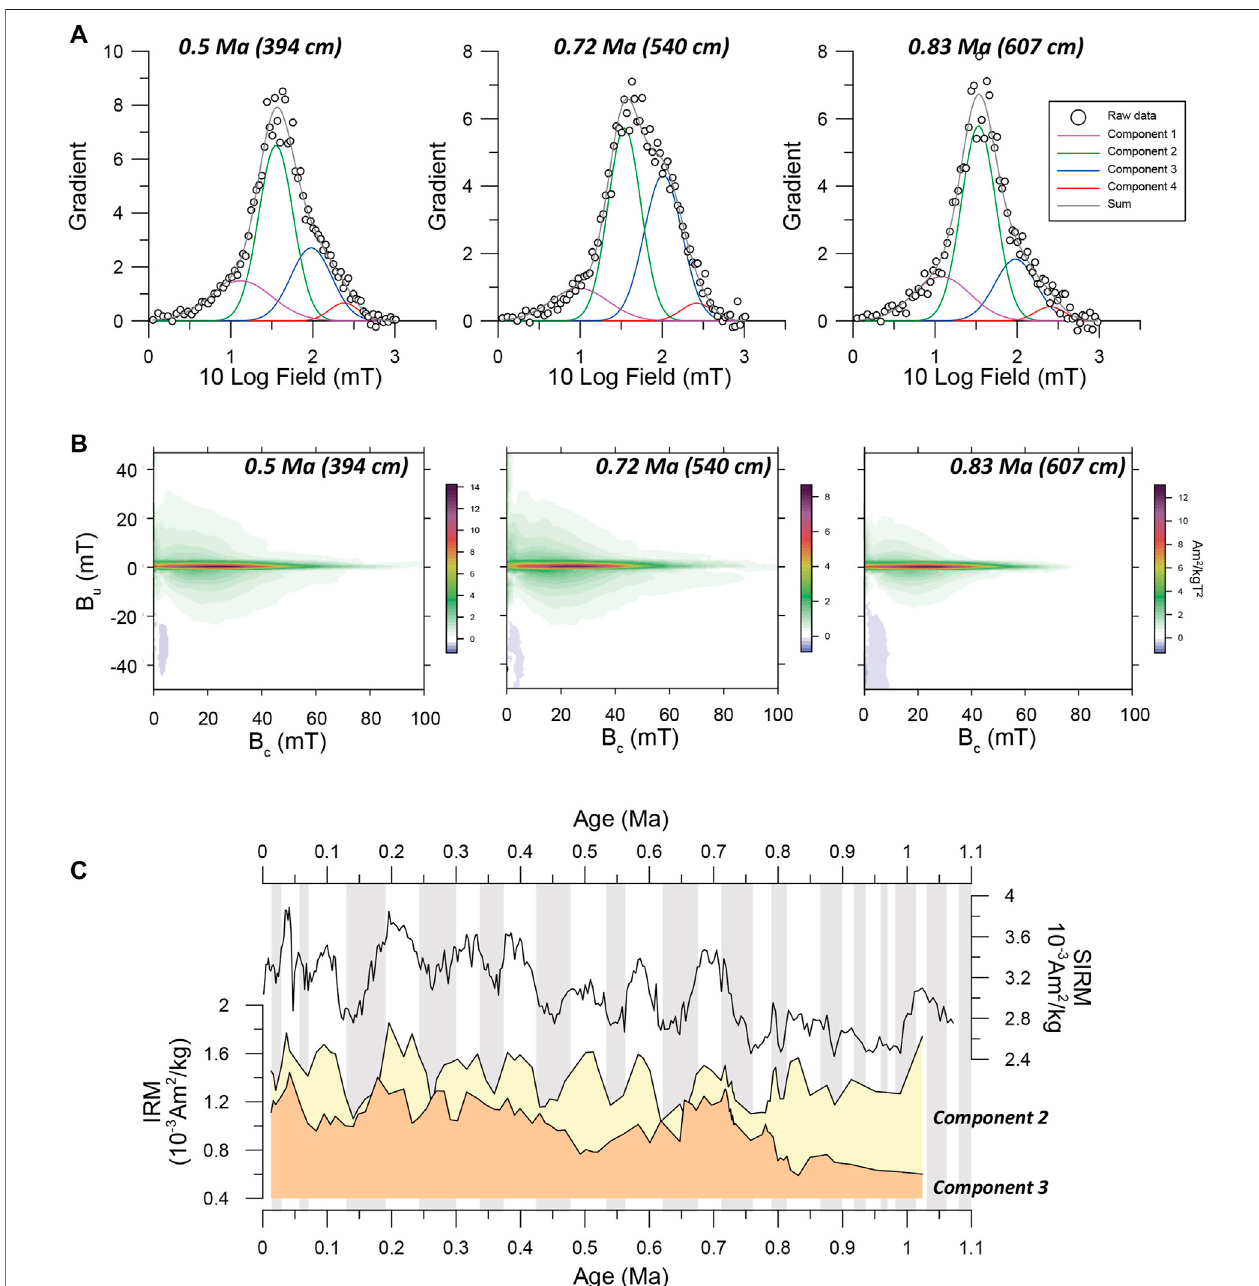
FIGURE 3 | IRM unmixing results and FORC diagrams for selected samples and temporal variation of IRM components. (A) IRM coercivity spectra and unmixing results; (B) FORC diagrams, and (C) comparison between SIRM and absolute concentrationof IRM components.IRM components (Component 1 – 4) are presented as purple,green,blue,andredlines,respectively.Thesumofcomponentsdelineatesthebest- fi ttedcoercivityspectra.AbsoluteIRMvalues(IRM (cid:1) percentagecontribution (%) of component × SIRM) for the major components (Component 2 and 3) colored by yellow and orange, respectively.